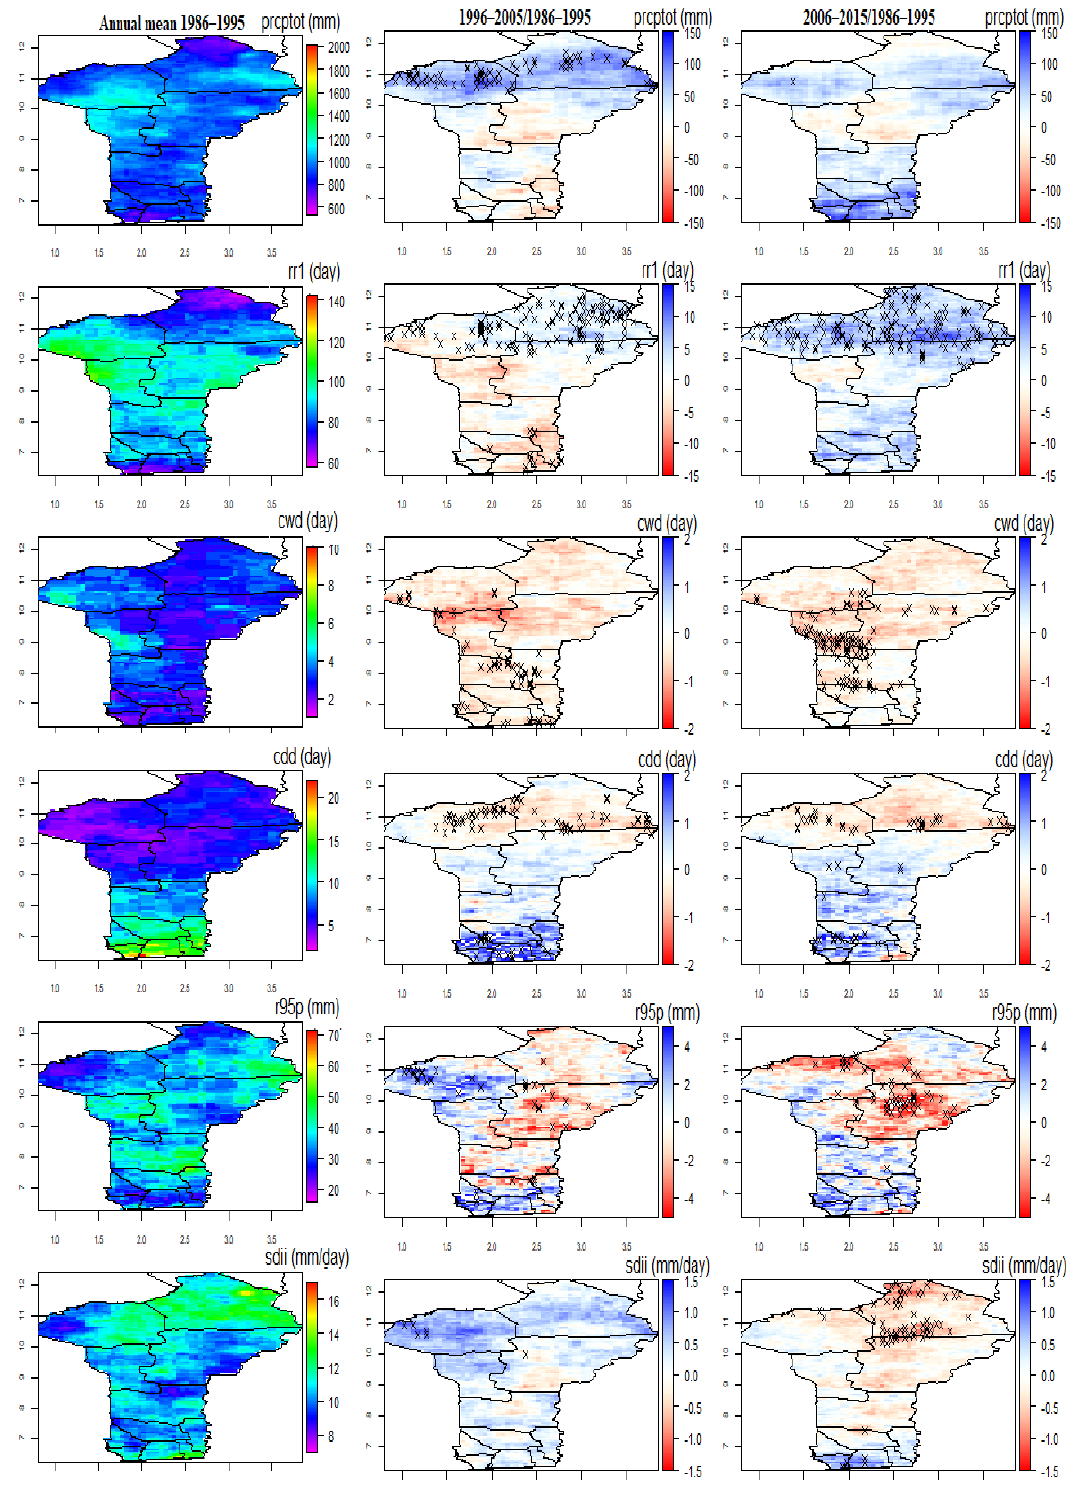
Figure 11. Spatial patterns of precipitation indices over Benin: mean over the reference decade 1986–1995 (first column); change over the 1996–2005 decade (second column) and changes over 2006–2015 decade relative to the reference decade (third column). Areas with the symbol (x) are significant at a 95% confidence level.